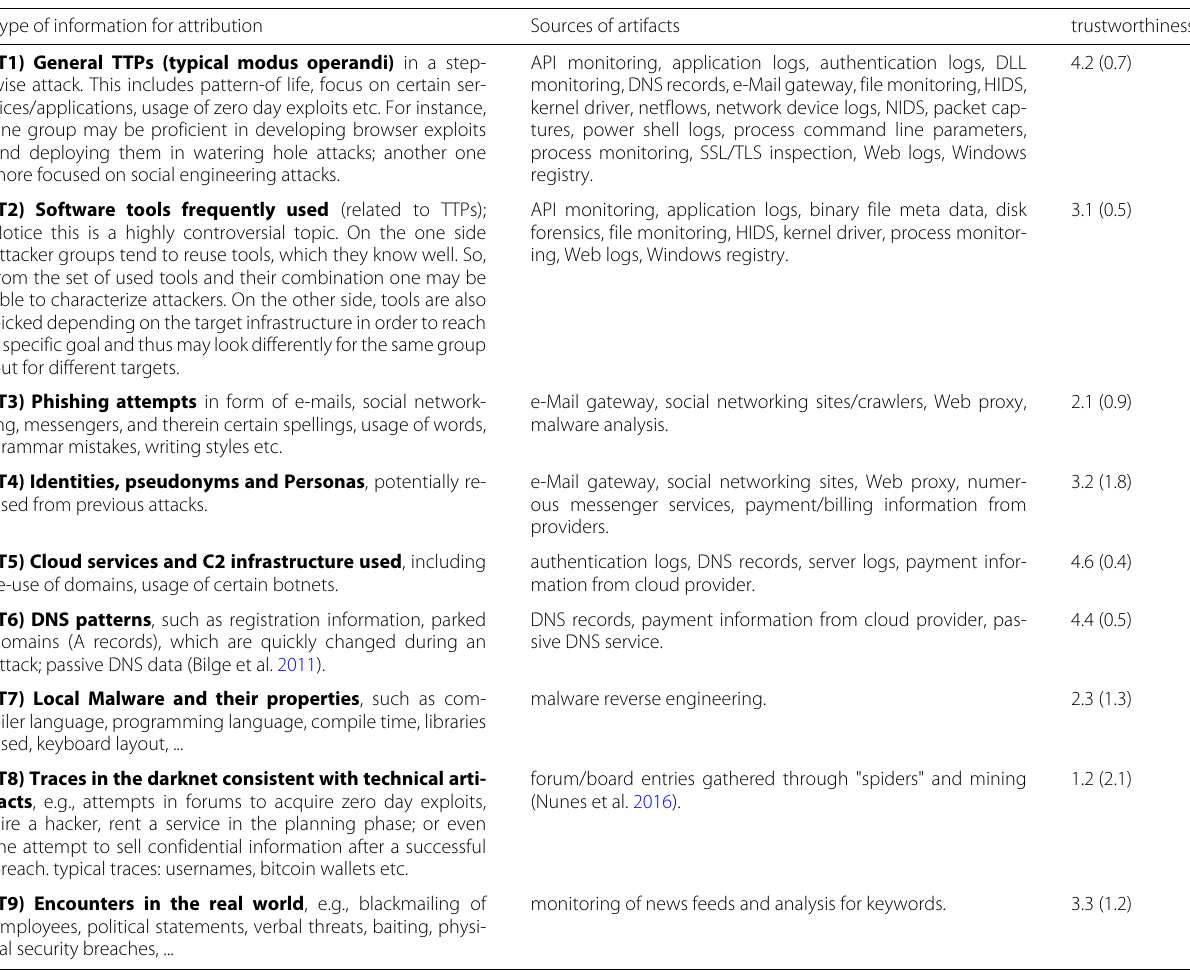
Table 1 Classes of information, derived from artifacts from various sources and an estimation of the trustworthiness of this information for attribution Type of information for attribution Sources of